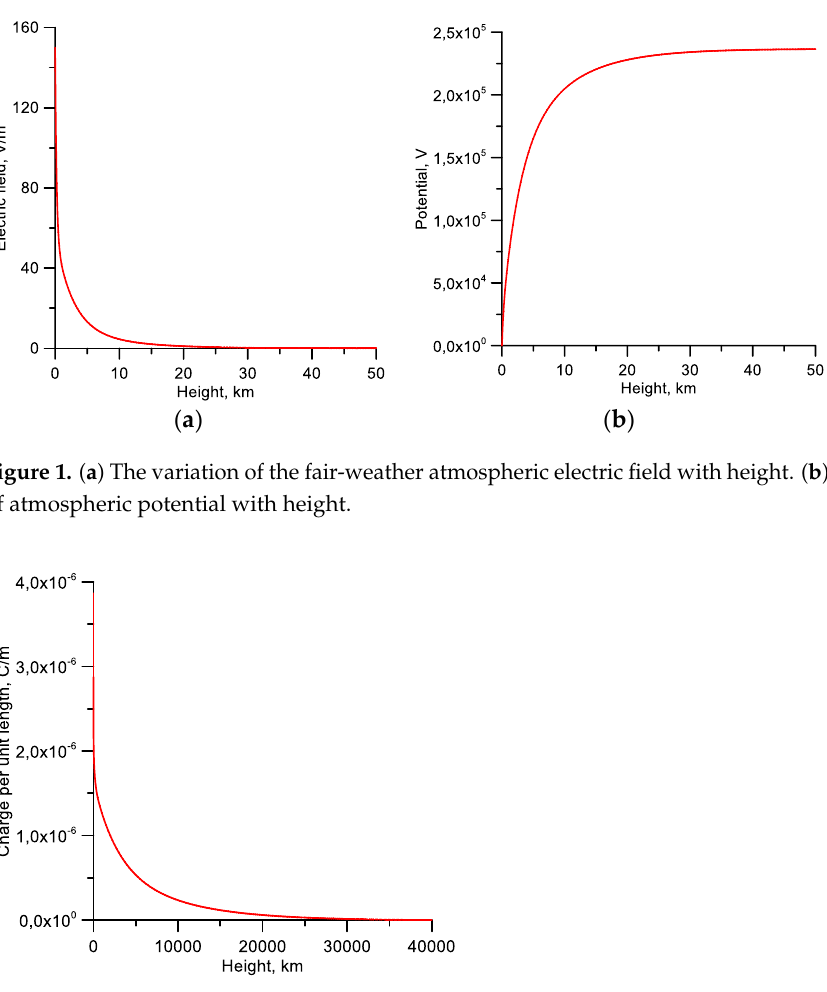
Figure 1. ( a ) The variation of the fair-weather atmospheric electric field with height. ( b ) The variation of atmospheric potential with height.